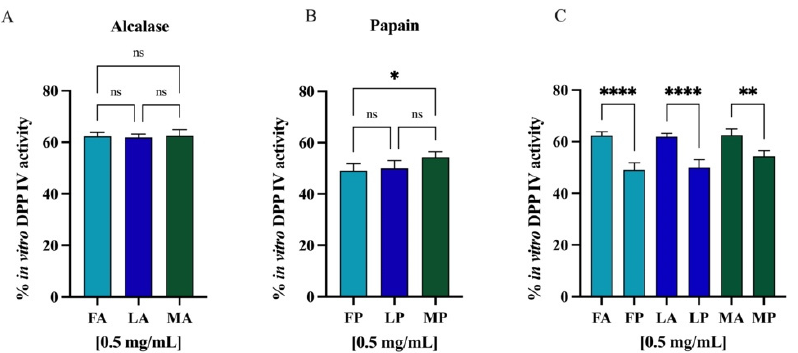
Figure 12. ( A ) Comparison between the cultivars hydrolyzed by alcalase, ( B ) the cultivars hydrolyzed by papain, and ( C ) the same cultivars hydrolyzed with different enzymes. Ns, not significant; (*) p < 0.5, (**) p < 0.01, (****) p < 0.0001.